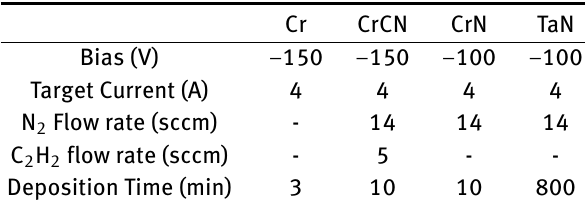
Table 1: Coating Parameters